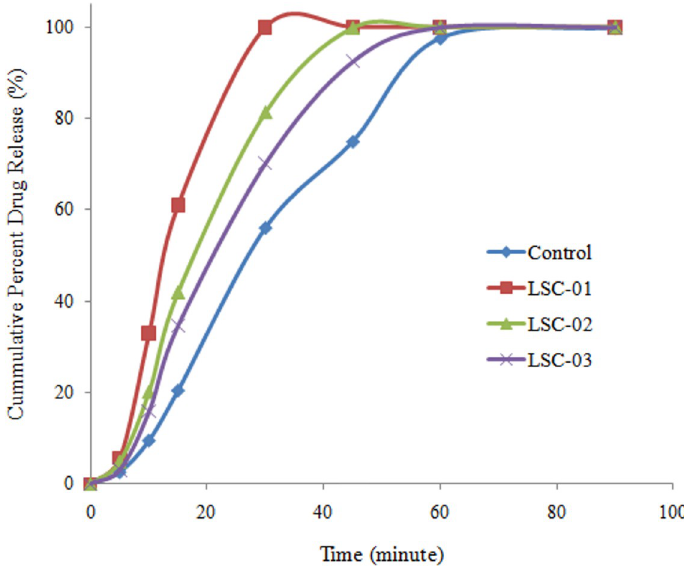
Fig 5. Drug release from liquisolid compacts containing different concentrations of